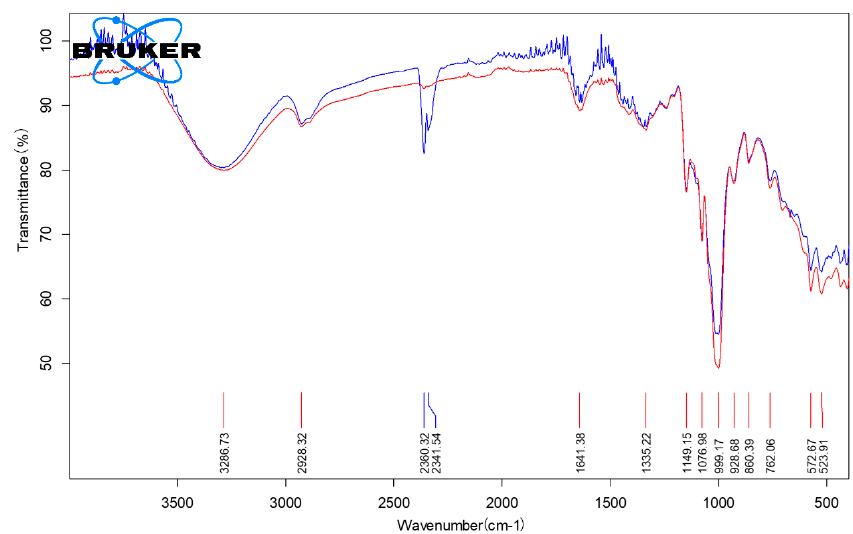
Figure 3. Overlay of the FT-IR spectrum of non-modified rice flour (red) and the spectra measured for modified rice flour (blue) in transmission mode.